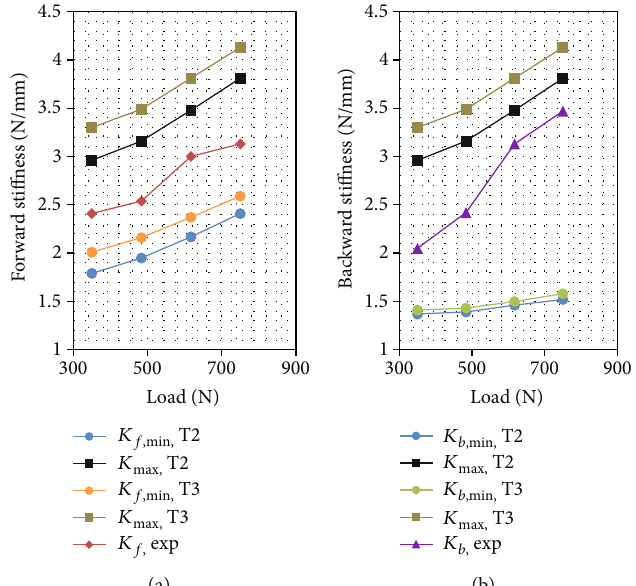
Figure 2: Bracketing of (a) forward and (b) backward trunk sti ff ness with respect to the load for tonus levels T2 (11%, 28%, and 36%) and T3 (19%, 28%, and 36%) for classes C1, C2, and C3, respectively.